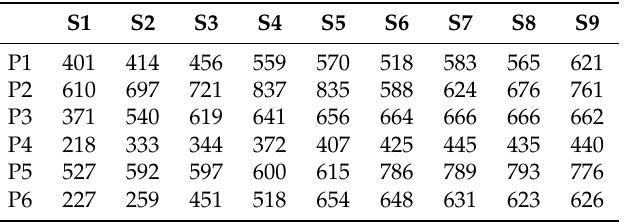
Table 5. RG_SCORE for each session of the whole set of exercises